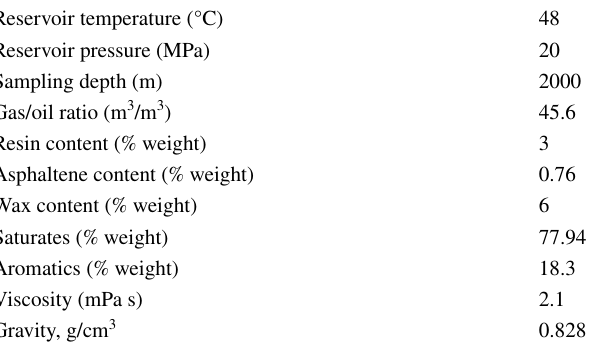
Table 1 Properties of the reservoir oil sample